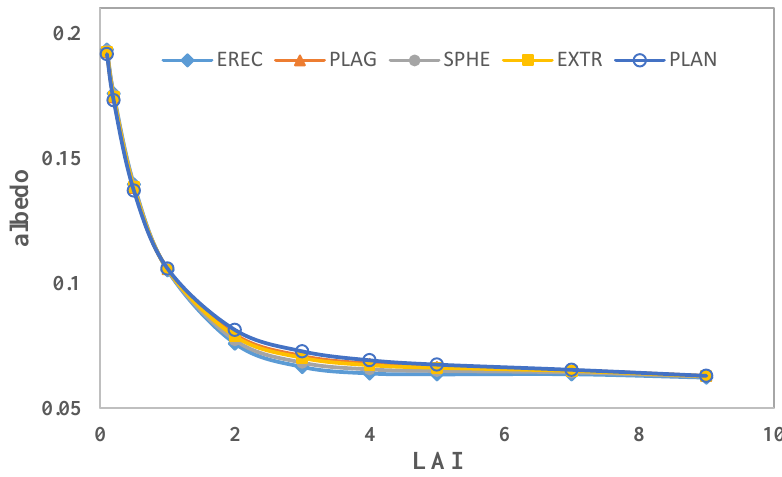
Figure 6. The canopy albedo derived from different G functions with changing LAI. (EREC- erectophile, PLAG-plagiophile, SPHE-spherical, EXTR-extremophile and